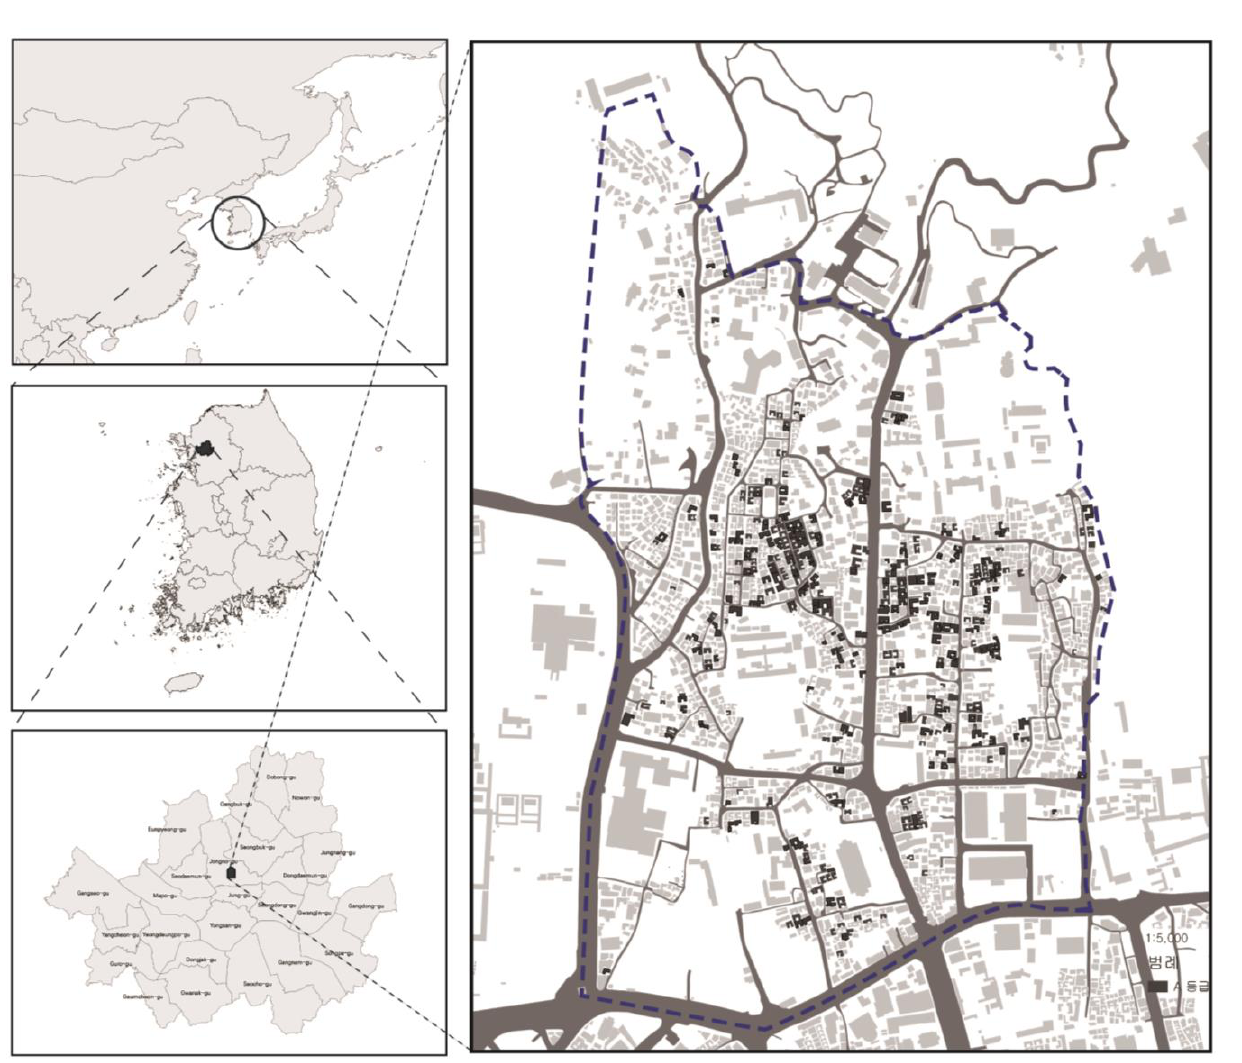
Figure 1. Location and target Hanok in the Bukchon area in Seoul, Korea.